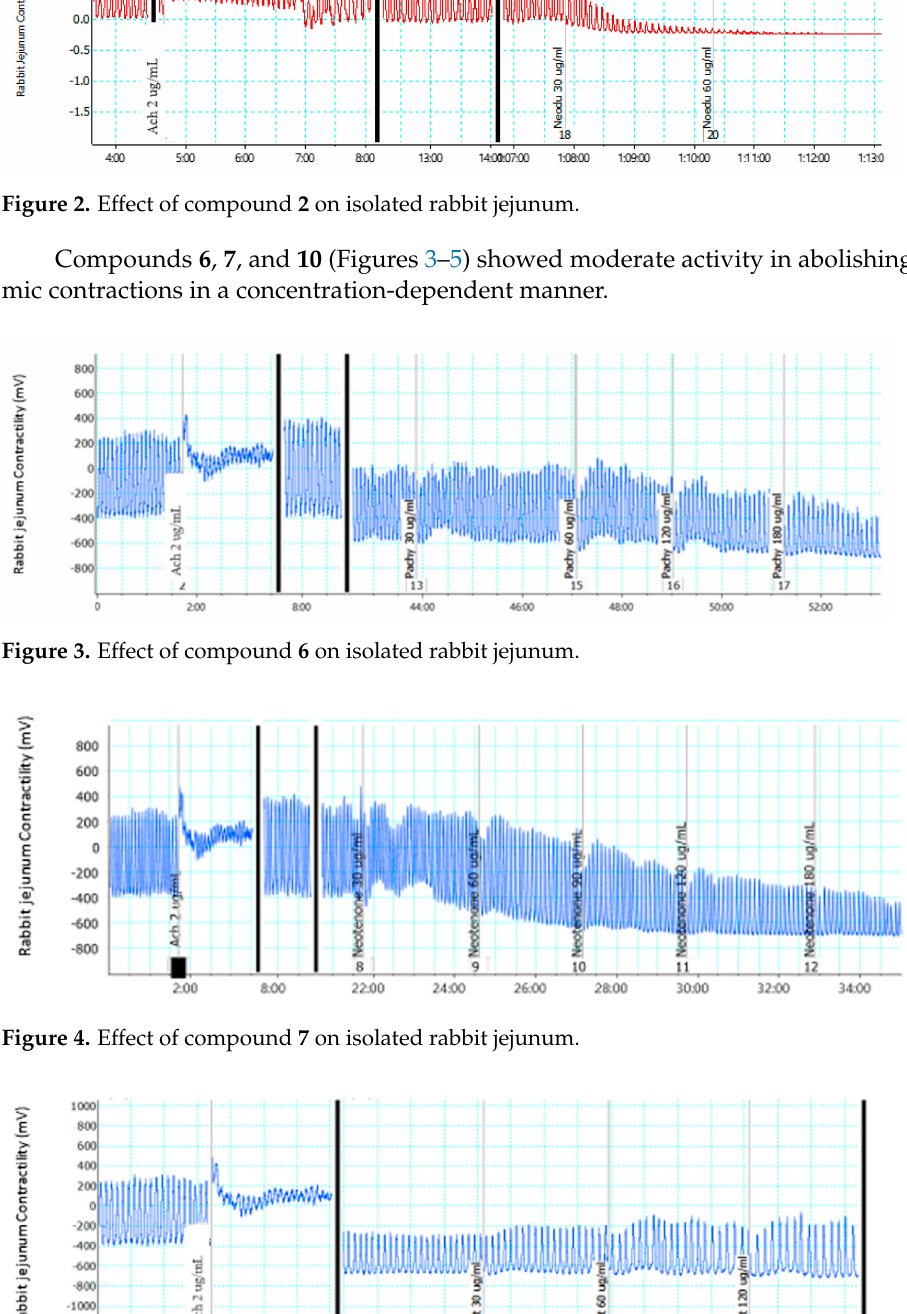
Figure 1. Compounds isolated from the DCM and aqueous root extracts of N. mitis [18].